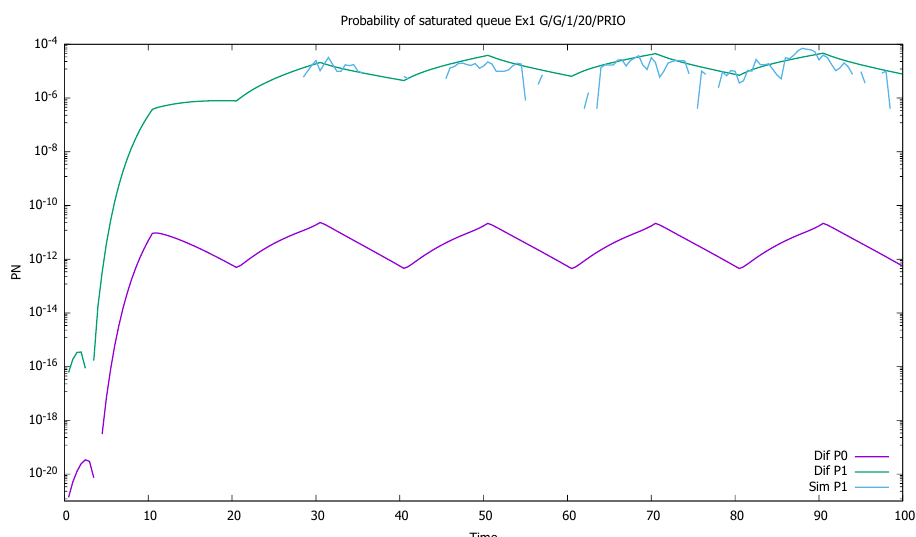
Figure 4. Section 3.1, low load: probabilities of saturated queues as a function of time for priority (P0) and non-priority (P1) classes.